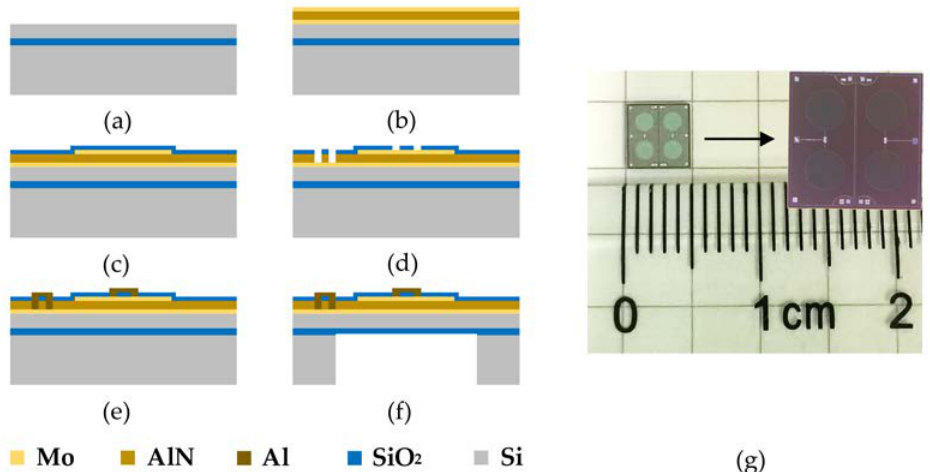
Figure 2. The PMUT array and MEMS hydrophone: ( a – f ) process flow, ( g ) optical image of the PMUT.